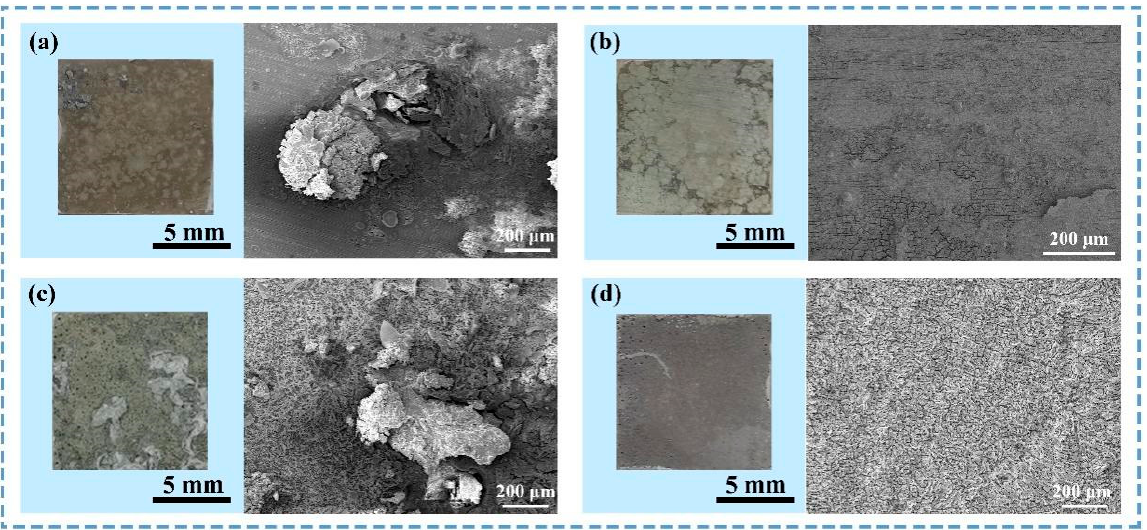
Figure 10. Optical and SEM images of surface morphology of ( a ) MA, ( b ) MA/CM, ( c ) MA/UC and ( d ) MA/UC/CM after immersion for 24 h.